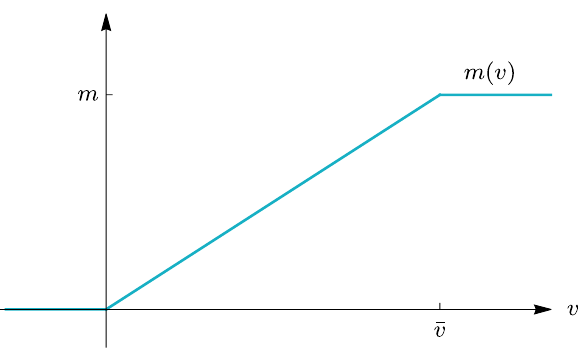
Figure 2 . Mass function of the classical VKP spacetime as given in eq. (4.1). The spacetime is initially flat. At v = 0 the gravitational collapse starts and the mass m ( v ) increases linearly with an injection rate λ . The collapse lasts until v = ¯ v , where the mass function m ( v ) reaches the plateau m ( v ) = m , m denoting the final mass of the black